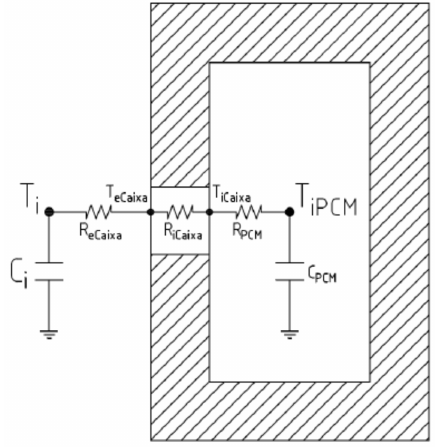
Figure 4. RC circuit representing the heat transfer inside the device and between the device and the room air. Ti represents the room air temperature; TiPCM is the PCM temperature [24].